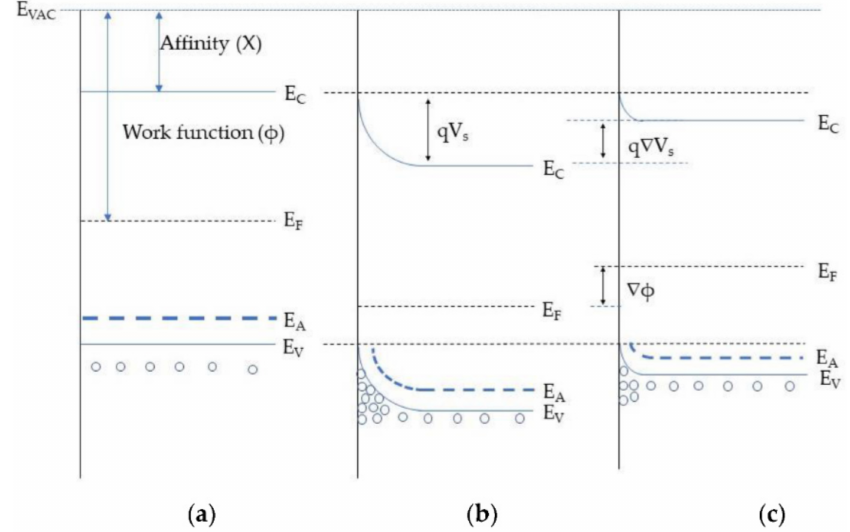
Figure 2. Energy-band structure at the near surface when interacting with oxygen and reducing gases: ( a ) Prior to any surface interaction. ( b ) Electron trapping and formation of the hole-accumulating layer due to oxygen adsorption. ( c ) The decrease in surface charge due to the interaction with the reducing gas. E C is the conduction-band position; E F is the Fermi-level position; Ev is the valance-band position; q is electron charge; qV S is the potential barrier. Reprinted with permission from